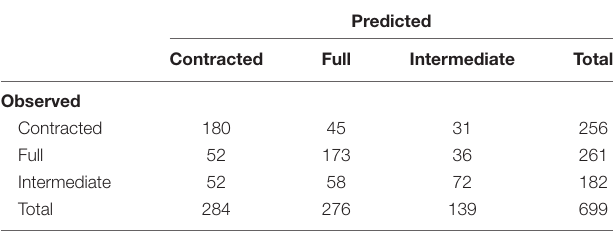
TABLE 4 | Confusion matrix for has